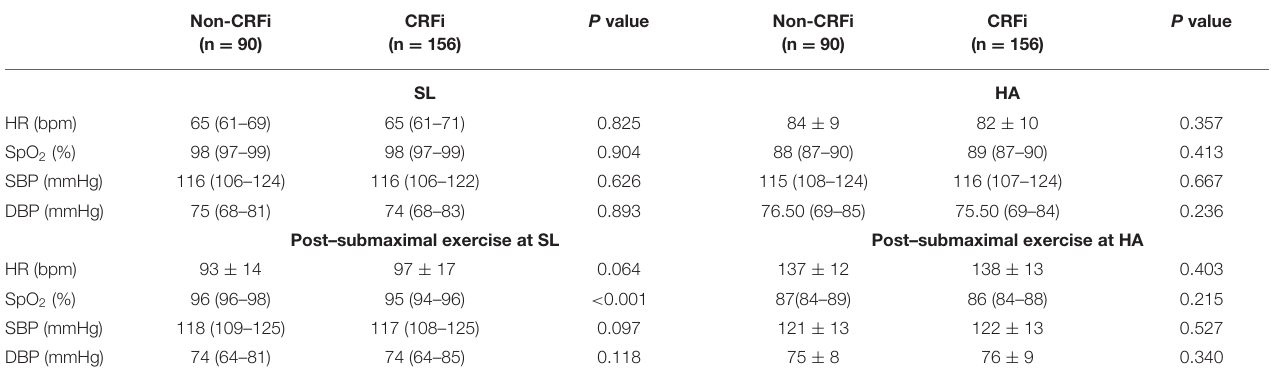
TABLE 3 | Physiological parameters in CRFi and non-impairment groups.